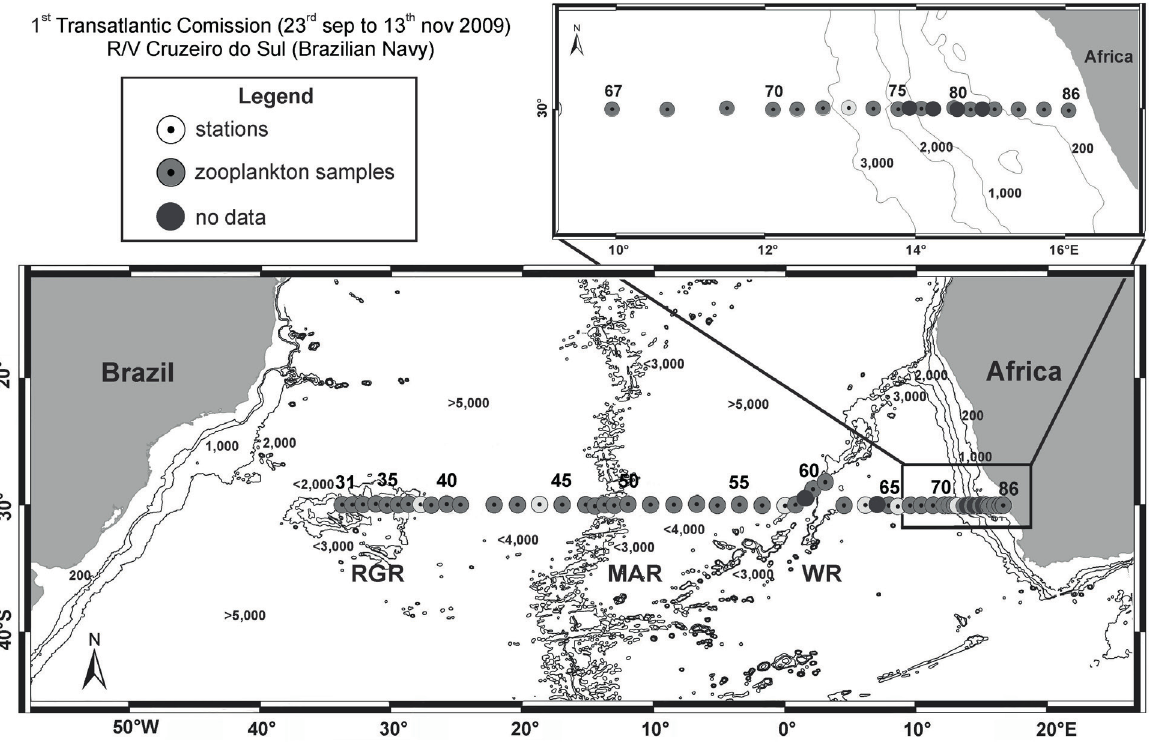
Figure 1 - Study transect through the South Atlantic Ocean at 30 °S with the 56 oceanographic stations. Bathymetry and oceanic rises are also indicated. Where: Rio Grande Rise (RGR), Mid-Atlantic Ridge (MAR), and Walvis Ridge